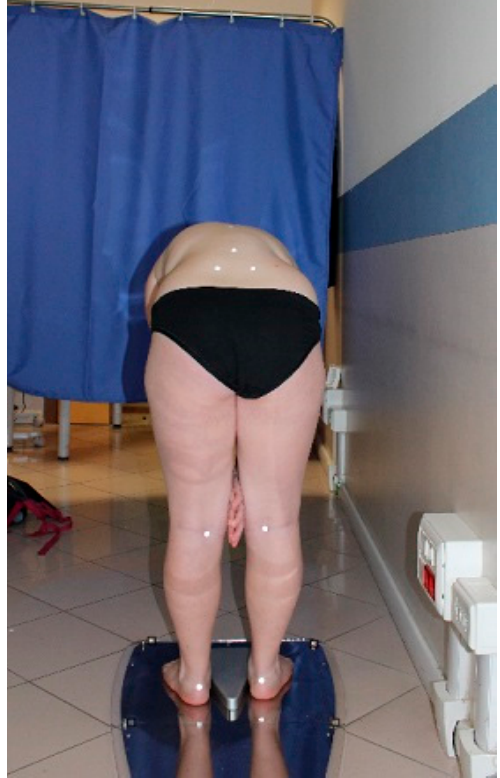
Figure 4. The prominence in an Adams test.